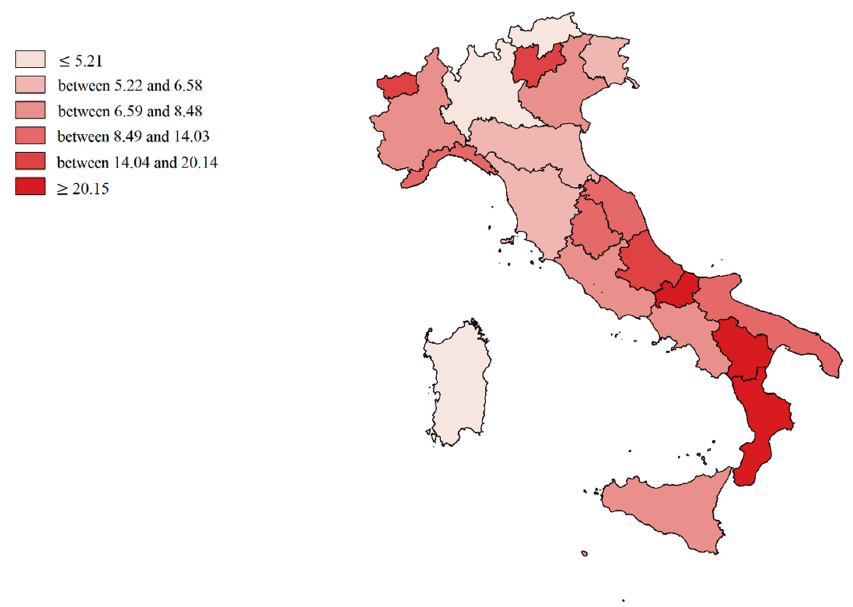
Figure 4. Cartographic representation of Escapes Indexes (EI), mean from 2013 to 2017.